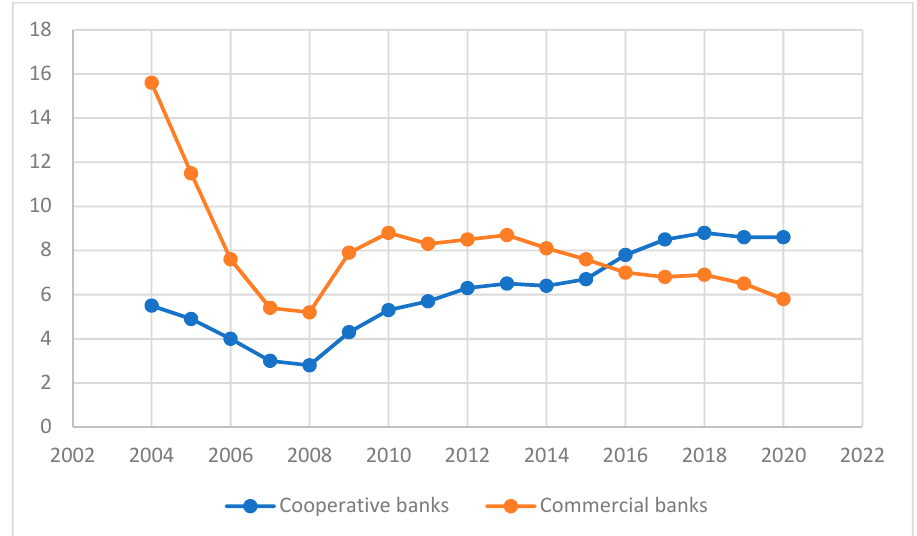
Figure 1. NPL level in commercial and cooperative banks in Poland in 2004–2020 (in%).